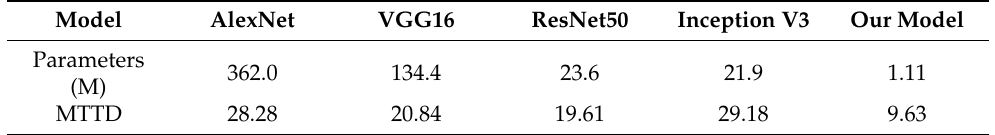
Table 7. Parameters and MTTDs of the tested